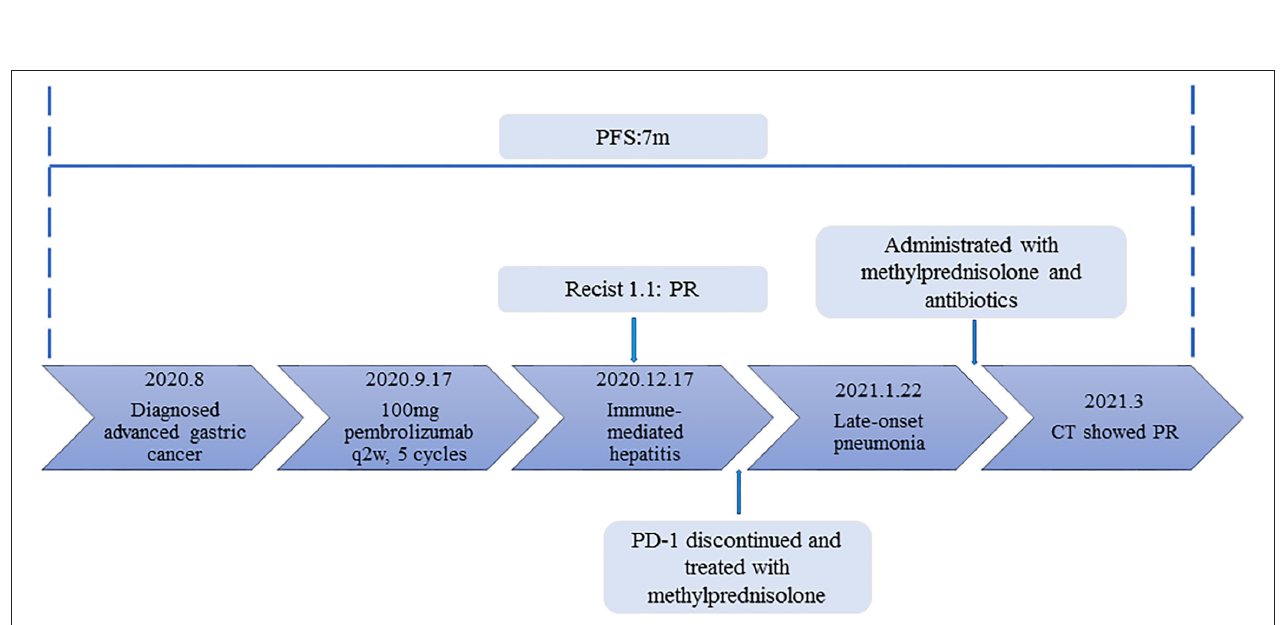
FIGURE 2 | The timeline of diagnosis, treatment and related immune-side effects of this patient since diagnosis.